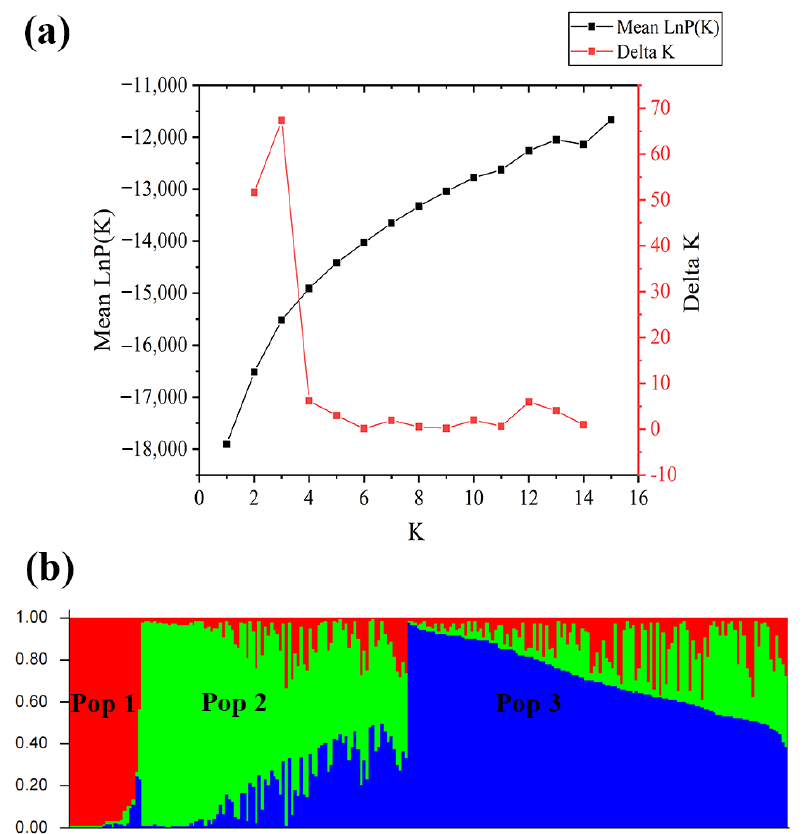
Figure 1. Population structure analysis of 240 accessions. ( a ) Mean lnP(K) (black) and Delta K (red) values for different assumed populations ( K ). The highest Delta K was obtained at K = 3, suggesting that the population could be divided into three sub-populations: Pop1, Pop2, and Pop3. ( b ) Q-values at K = 3 of 240 sweetpotato accessions.